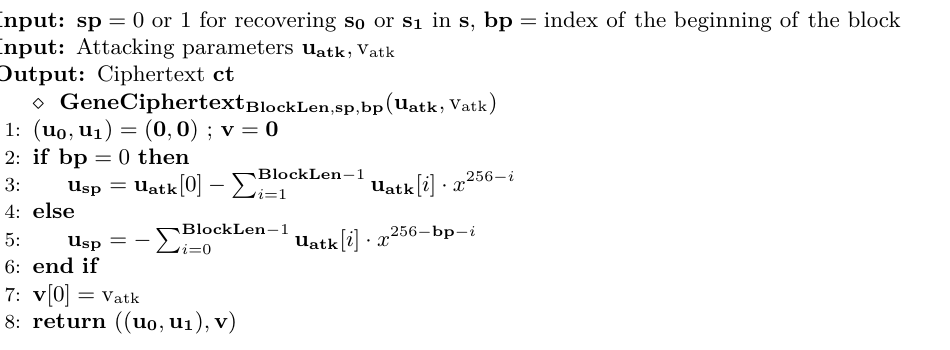
Algorithm 4 Generating candidate ciphertexts from given parameters